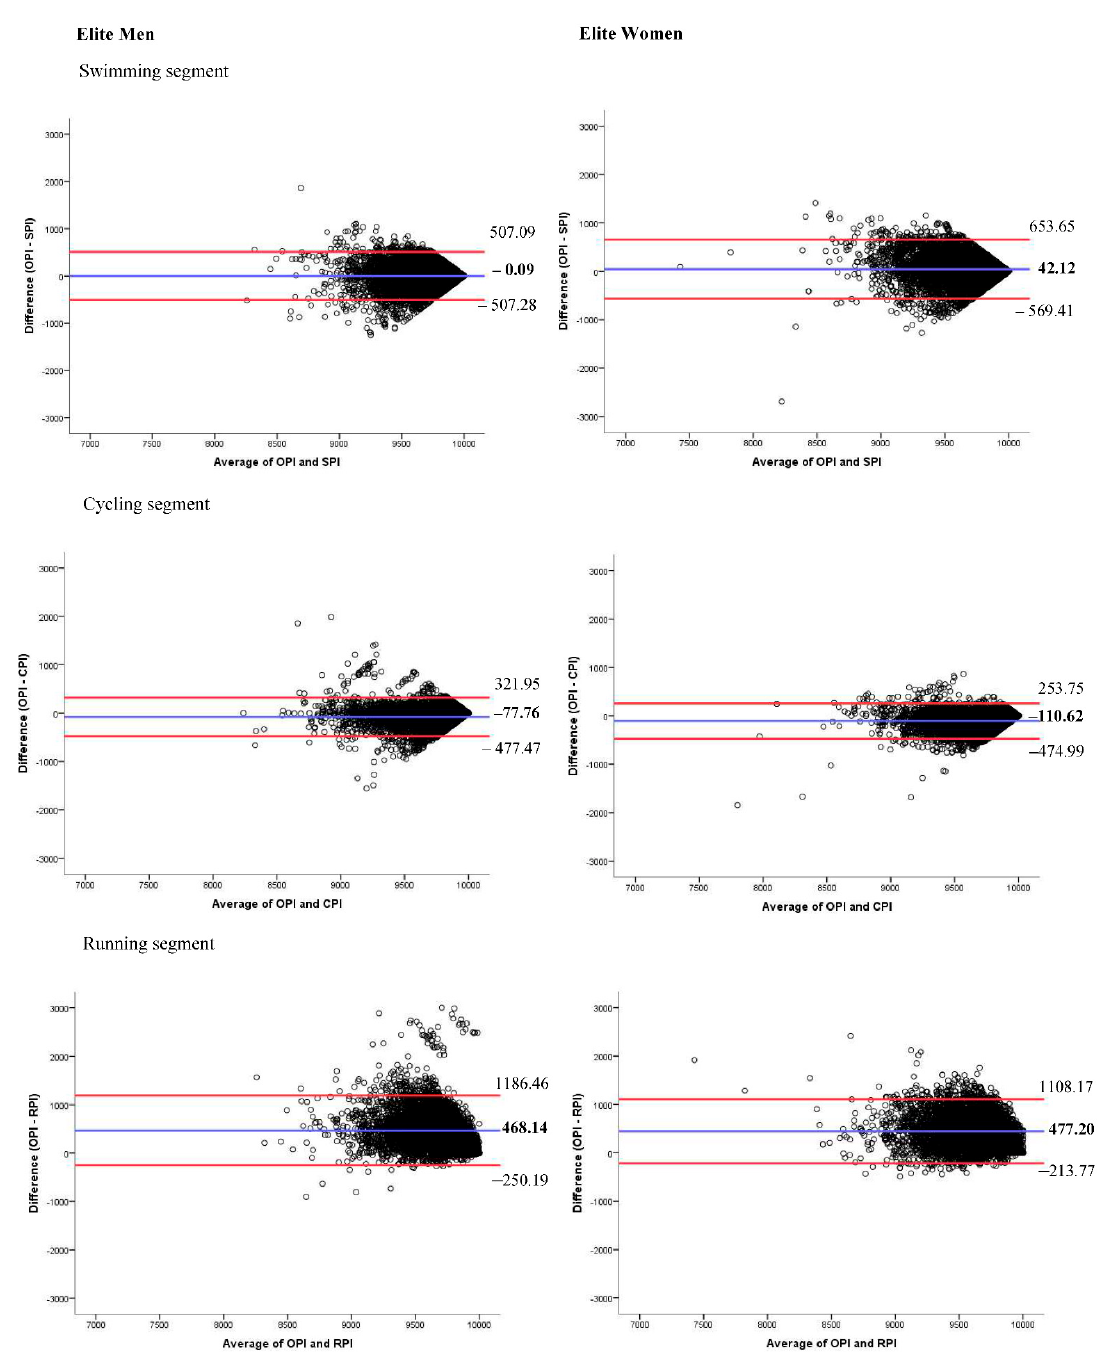
Figure 2. Bland–Altman plots between swimming performance indicator (SPI), cycling performance indicator (CPI), and running performance indicator (RPI) and overall performance indicator (OPI). The red lines represent the upper and lower 95% limits of agreement, whereas the blue line represents the bias.